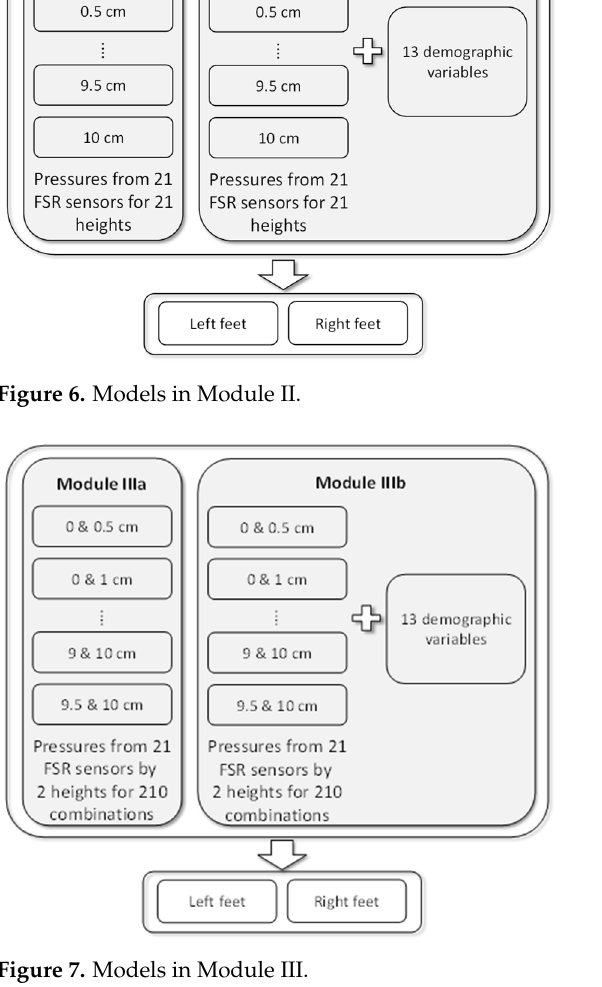
Figure 7. Models in Module